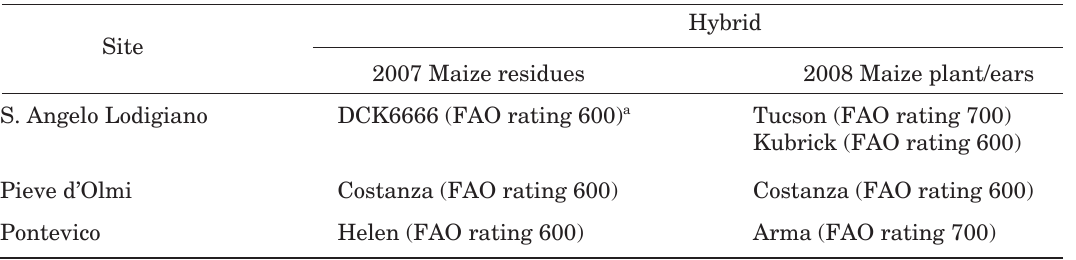
Table 1. Maize hybrids tested in 2007 and